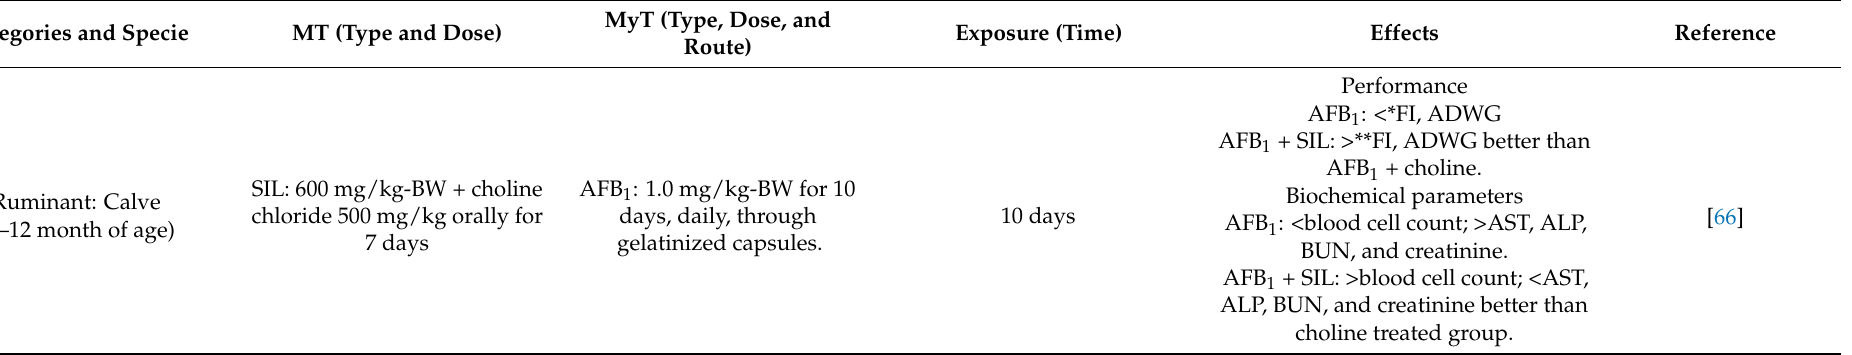
Table 3. Effects of milk thistle (MT) in other animal species, poisoned by different types of mycotoxins (MyT). If not diversely reported in the section effects the results are referred to the control group without